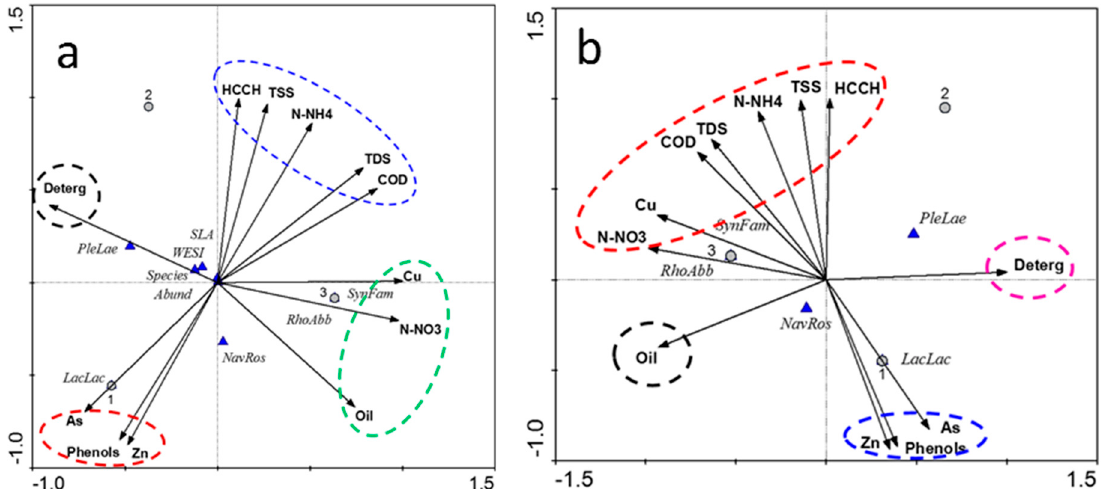
Figure 9. CCA plots of the three sites environmental variables and diatom species relationships in the Zarafshan River, 2009–2015; ( a )—abundant species, total abundance scores, species richness, indices Sl á deˇcek, and WESI; and ( b )—abundant species. Black arrows—environmental variables, blue triangles—diatom species, grey dots—sampling stations, dashed ovals—groups of environmental variables. 1, Khatirchi; 2, Pahtakor; 3, Navoi.